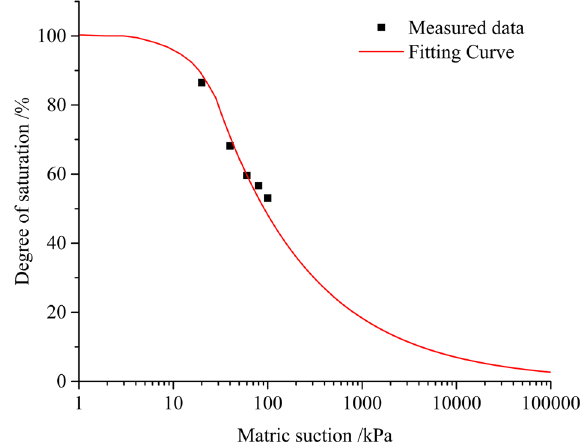
Figure 10. Fitting of SWCC of untreated loess.